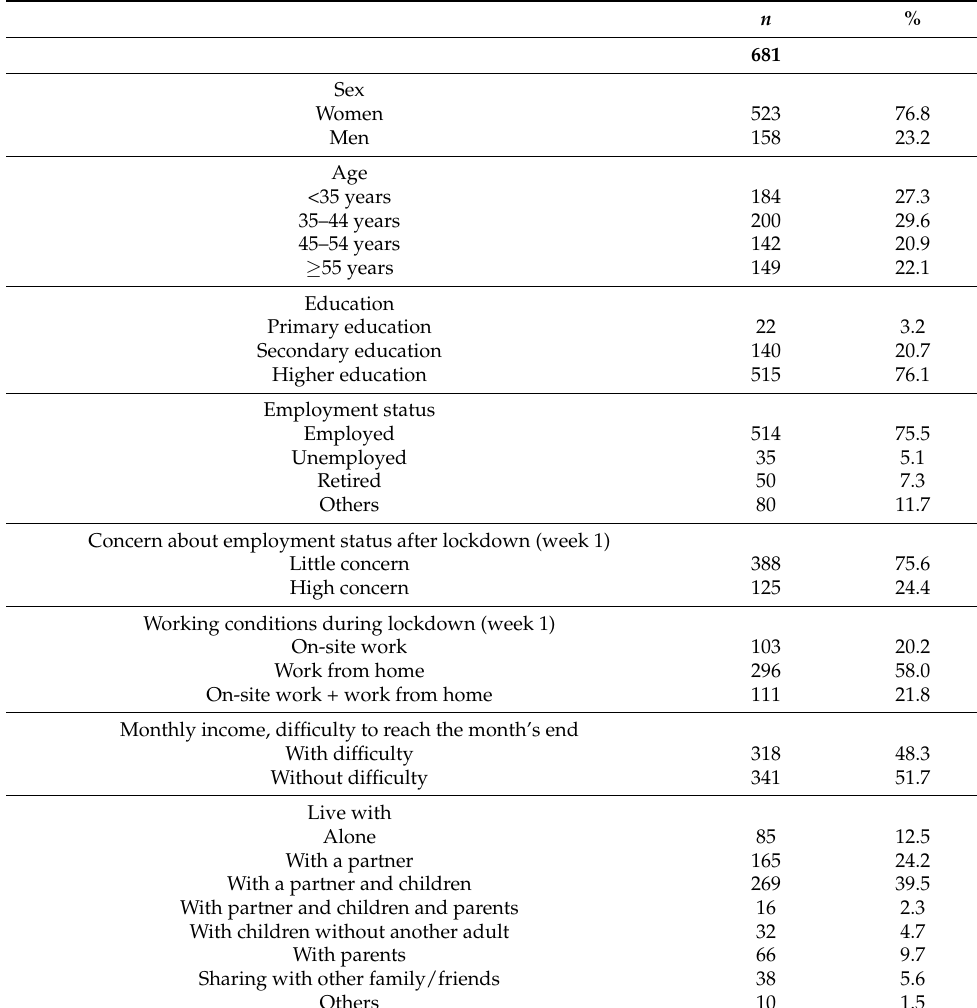
Table 2. Participant